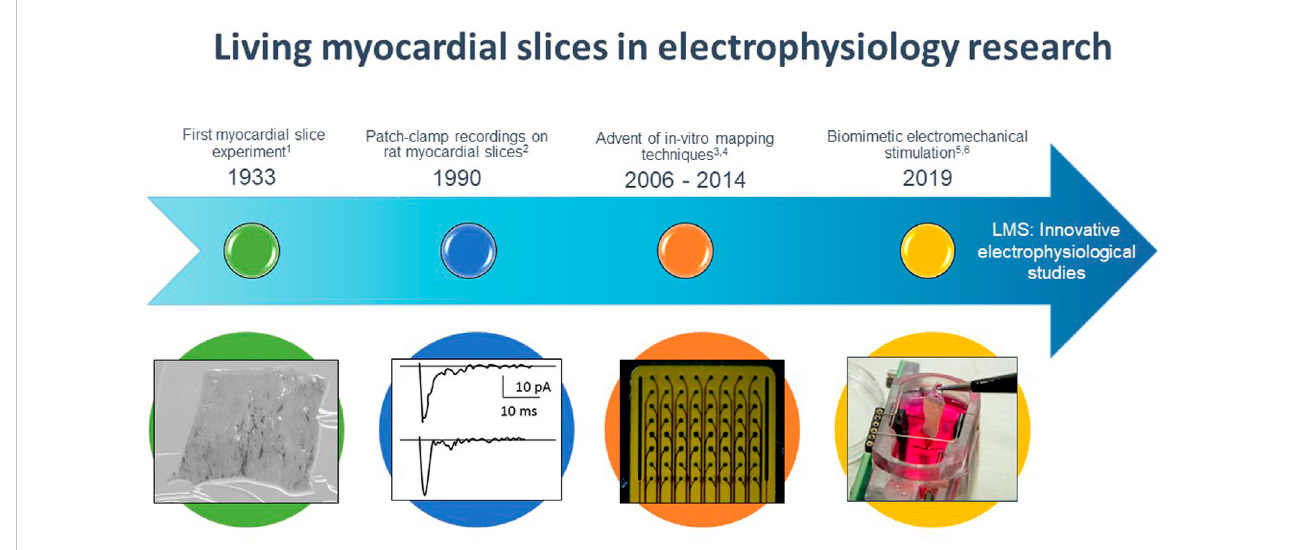
FIGURE 1 Timeline of major events for living myocardial slices (LMS) in electrophysiological research. 1 Pincus (1933), 2 Burnashev et al. (1990), 3 Halbach et al. (2006), 4 Wang et al. 2015, 5 Fischer et al. (2019), 6 Watson et al.